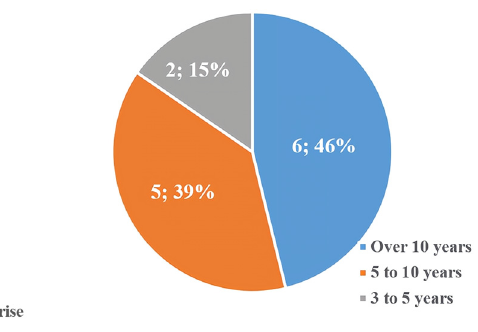
Figure 4. Information regarding the experts.